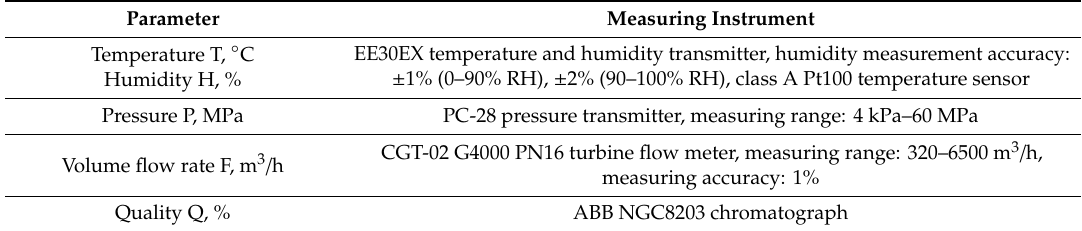
Table 3. Parameters of the air-methane mixture measured in the Pni ó wek coal mine [25].